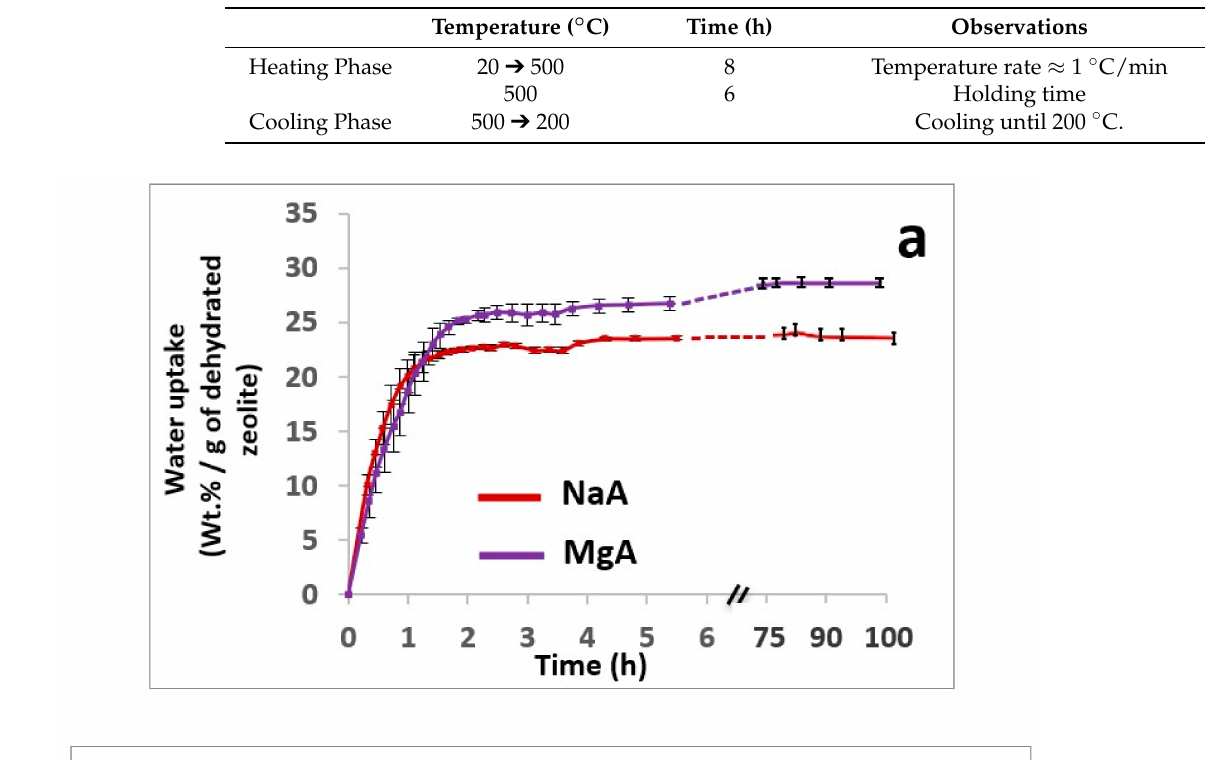
Table 7. Oven temperature program for the dehydration of zeolite powder samples.